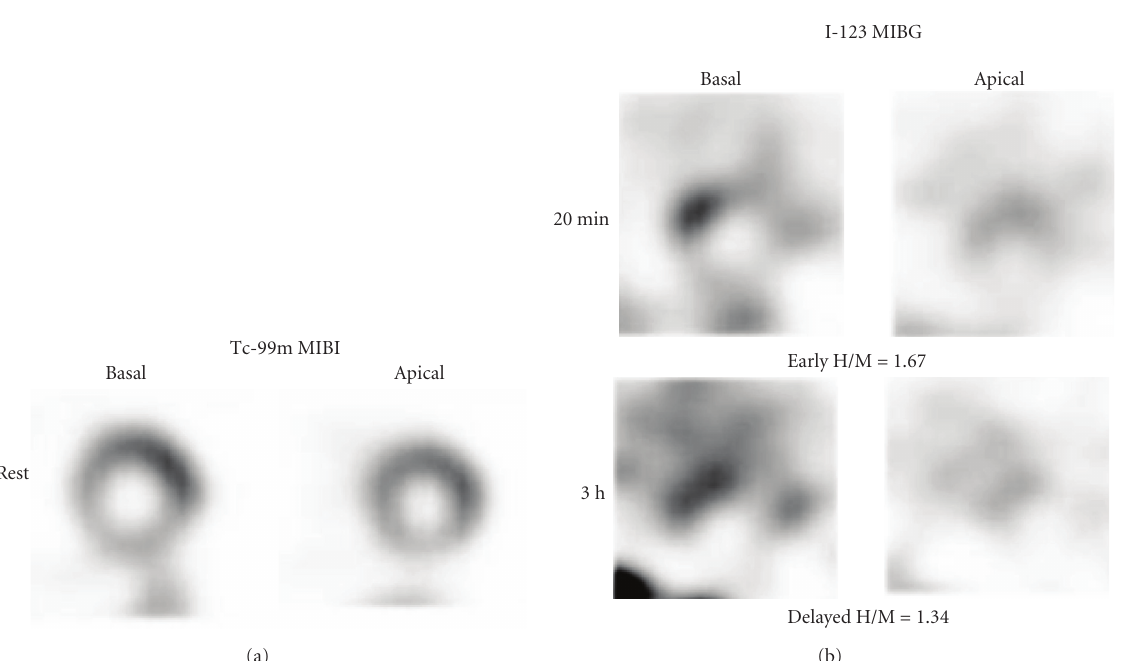
Figure 2: A patient with di ff use cutaneous type with MRSS 21, showing decreased MIBG activity and rapid washout rate (33%). 123 I-MIBG distribution showed marked heterogeneity in both early and delayed short-axis images. Resting perfusion was normal by 99m Tc-MIBI SPECT. Adapted from [41].